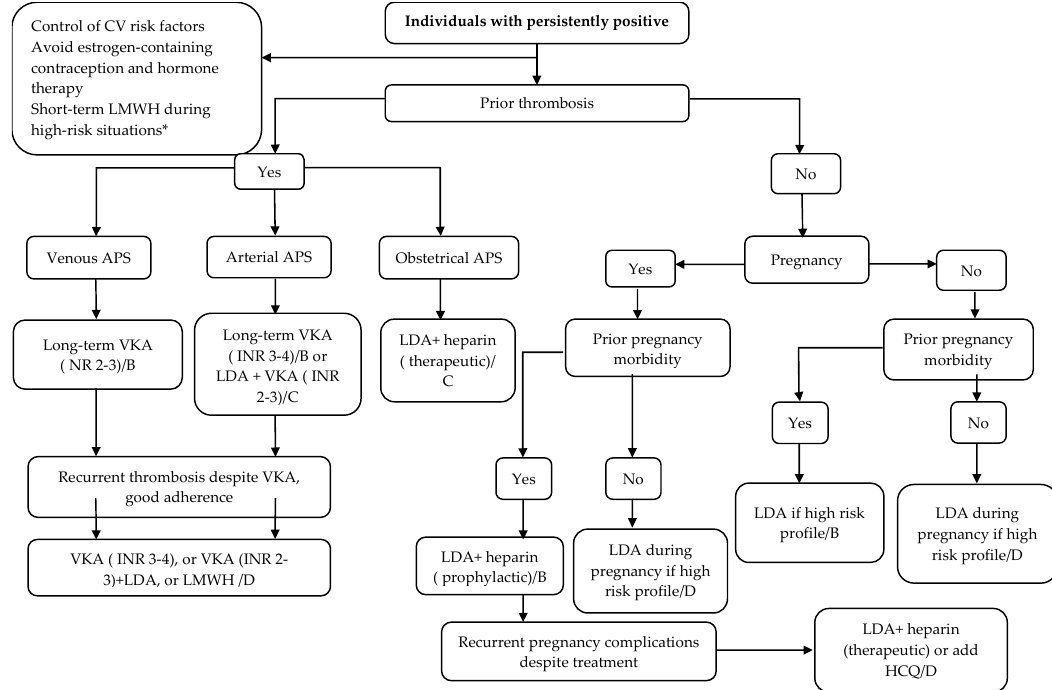
Figure 1. Treatment algorithm for antiphospholipid syndrome, adapted from [29]. aPL = antiphospholipid antibodies; CV = cardiovascular; DOAC = direct oral anticoagulant; INR = international normalized ratio; LDA = low dose aspirin; LMWH = low molecular weight heparin; VKA = vitamin k antagonist. Recommendation grade: B: consistent level 2 or 3 studies, or extrapolations from level 1 studies; C: level 4 studies or extrapolations from level 2 or 3 studies; D: level 5 evidence or troublingly inconsistent or inconclusive studies of any level. * Surgery, pregnancy/postpartum, and immobilization.